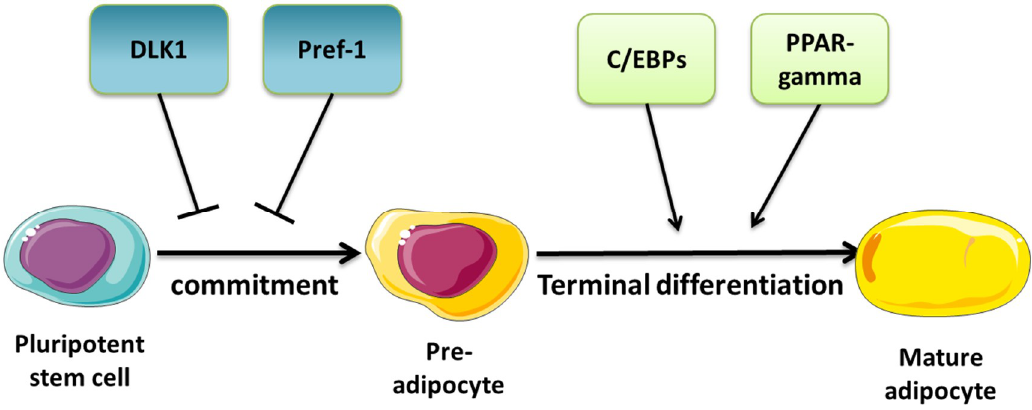
Figure 1. Phases of the adipogenic differentiation. Abbreviations: DLK1—delta‐like homolog 1, Pref-1—preadipocyte factor 1.